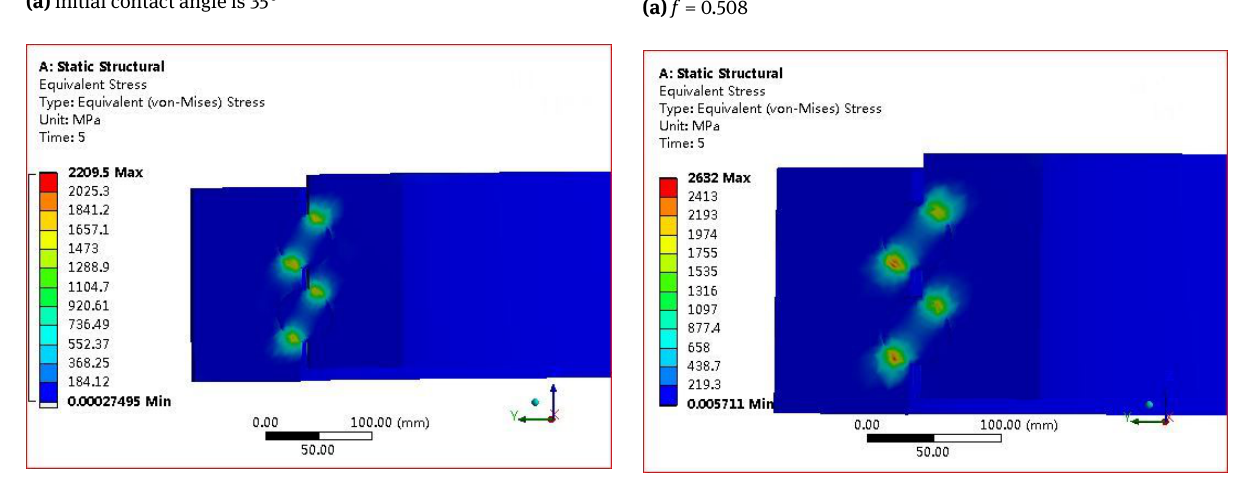
Figure 20: Equivalent stress distribution for different groove curva- ture radius